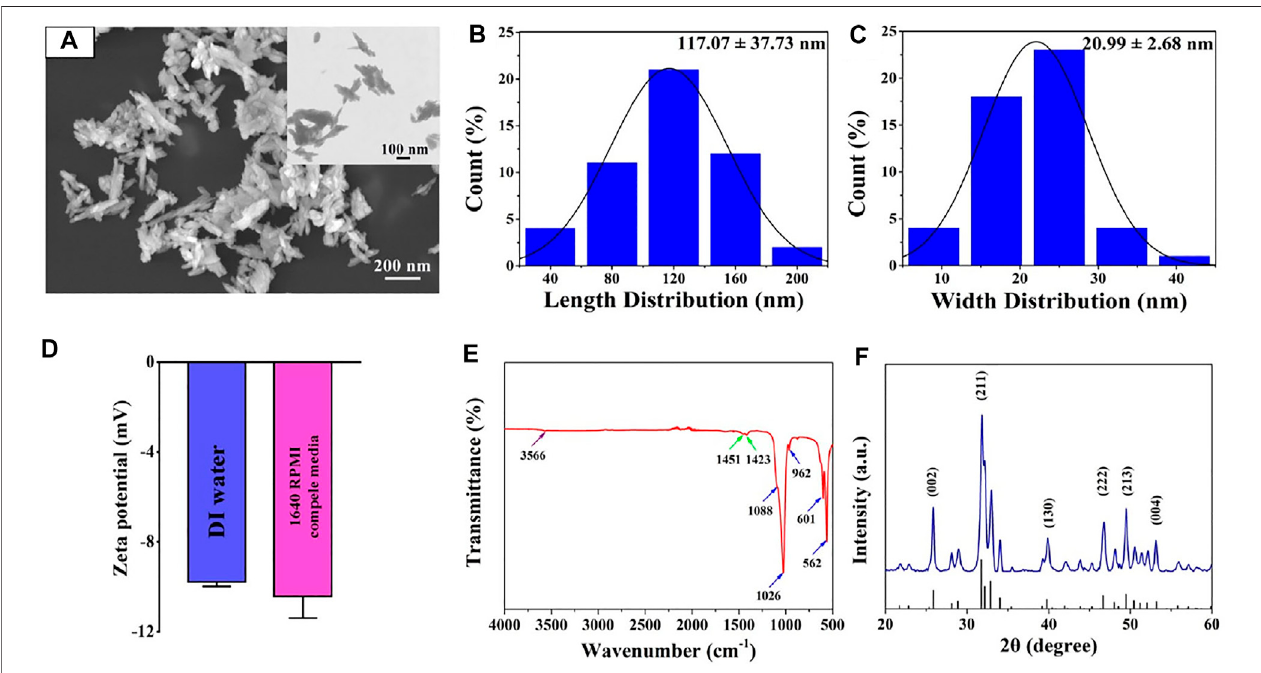
FIGURE2|(A) FE-SEMimageofnHA. (B,C) LengthandwidthsizedistributionofnHA. (D) ZetapotentialofnHAinDIwaterand1640RPMIcompletemedium. (E) FT-IR spectrum of nHA. The purple, green and blue arrows indicated OH-, CO32- and PO43- groups, respectively. (F) XRD pattern of